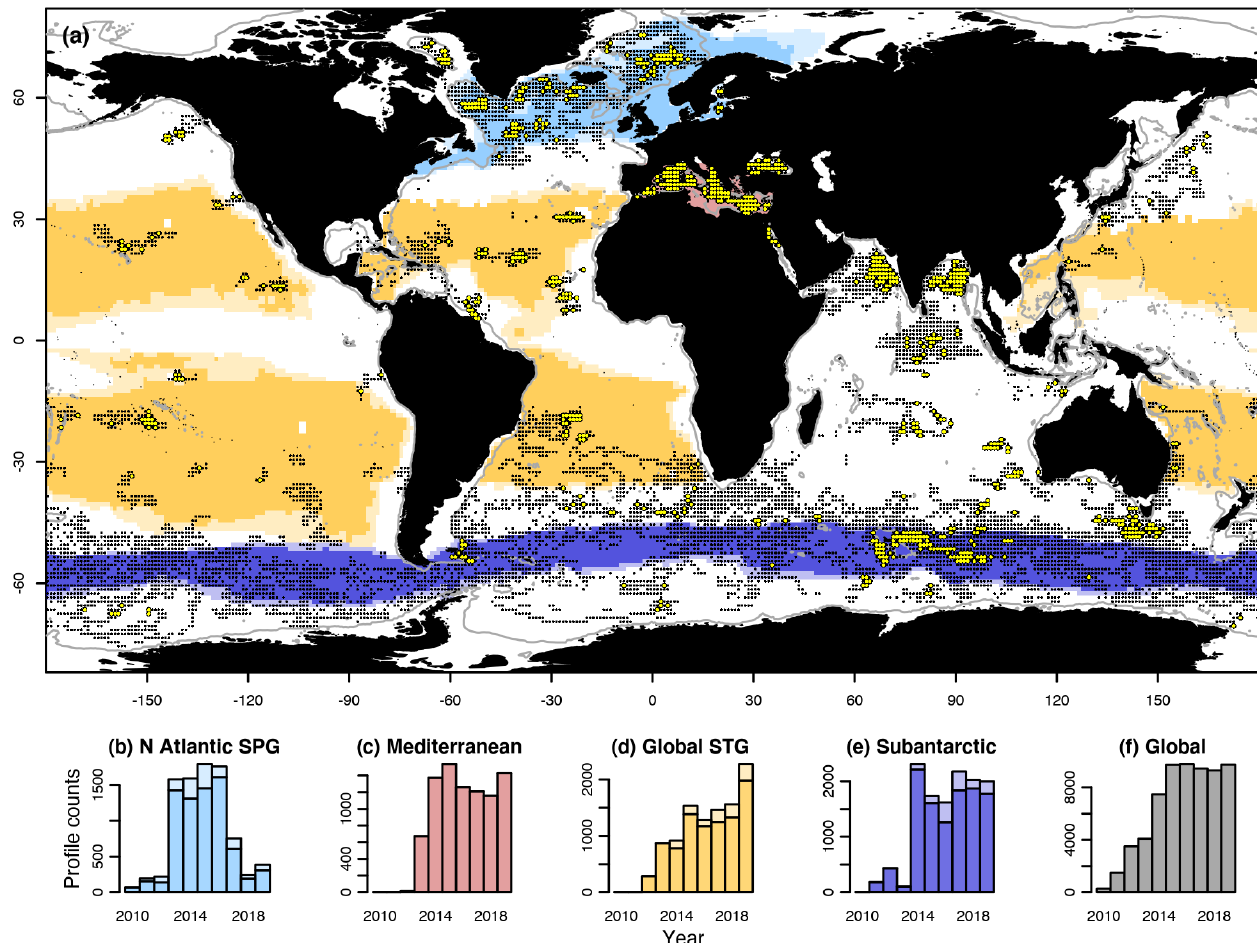
Figure 1. Global distribution and abundance of BGC-Argo profiles between 2010 and 2019. Grid cells (1 ◦ × 1 ◦ ) with at least one profile of the backscattering coefficient at 700nm ( b bp700 ) are marked with black dots, and those with at least 20 profiles are marked with yellow-filled circles. The gray contours indicate the 1000m isobath. Color shading indicates ocean biomes (see text), whose names are indicated on top of the bottom histograms. For each biome, light color indicates its average extent over 13 years of satellite observations (1998–2010), whereas the darker color indicates the “core” grid cells that never changed biome classification during the same period. The bottom panels (b–f) show the number of BGC-Argo b bp700 profiles per year in the four selected biomes and in the global